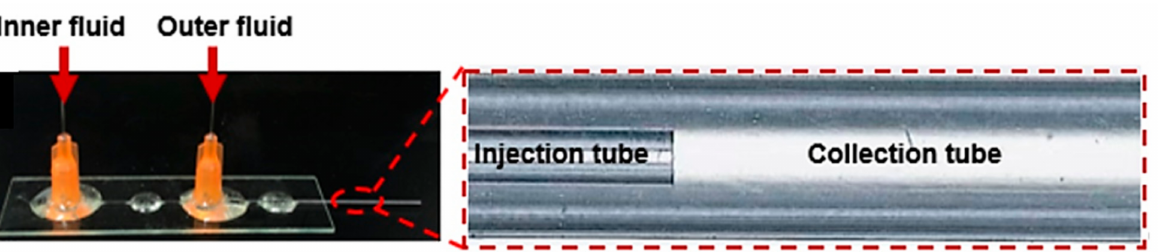
Figure 9. Microfluidic device with a co-flow structure developed by Xia et al. Reprinted from an open-access source